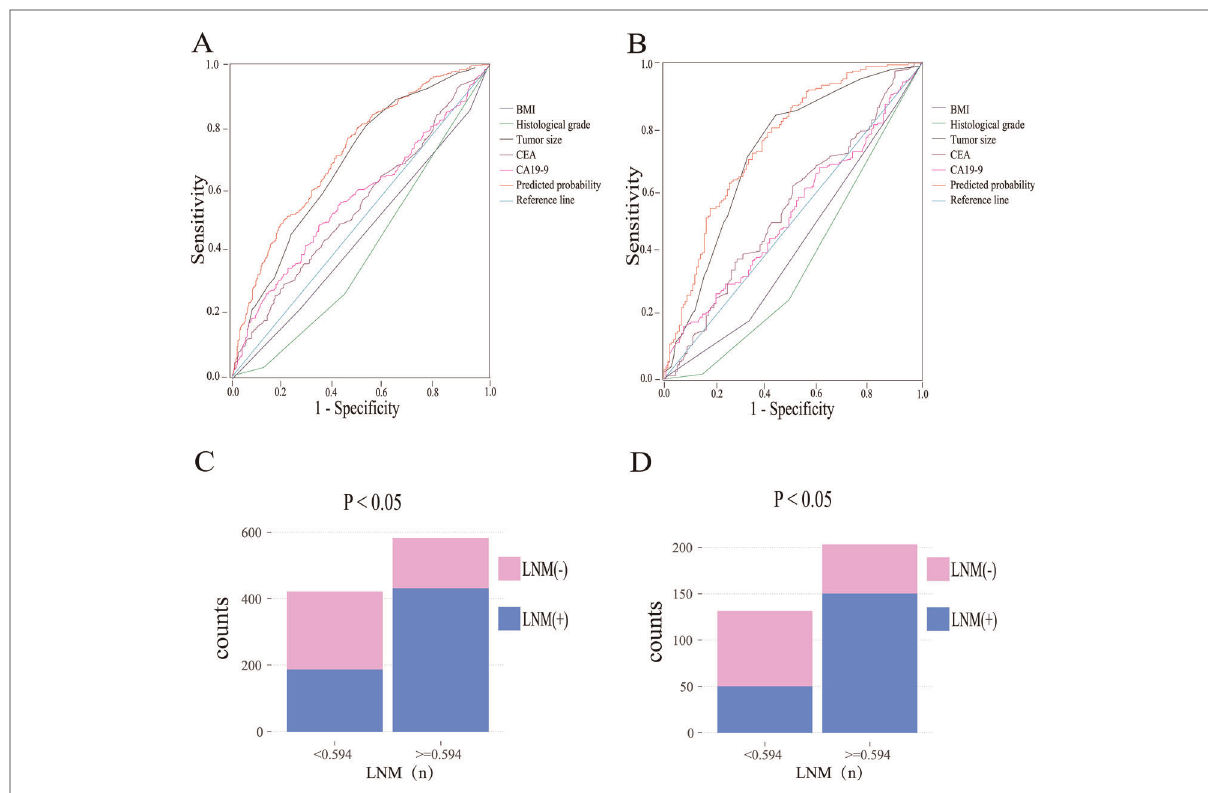
FIGURE 1 ROC curves and proportion of LNM in the low-risk group and high-risk group in the training cohort ( A,C ). ROC curves and proportion of LNM in the low-risk group and high-risk group in the validation cohort ( B,D ). Abbreviation: BMI, body mass index; CEA, carcinoembryonic antigen; CA19-9, cancer antigen19-9; LNM, lymph node metastasis.